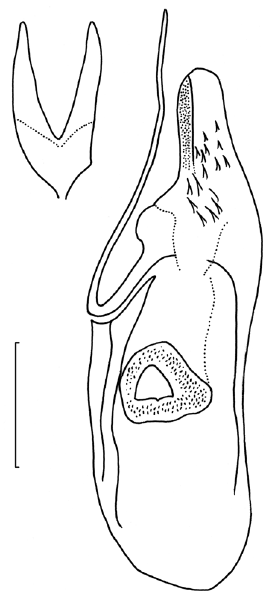
Figure 104. Neotrifurcula gielisorum , phallus and juxta (top left), ventral view, holotype. Scale: 100 µm. Measurements . Female: forewing length 3.8mm, wingspan 8.2